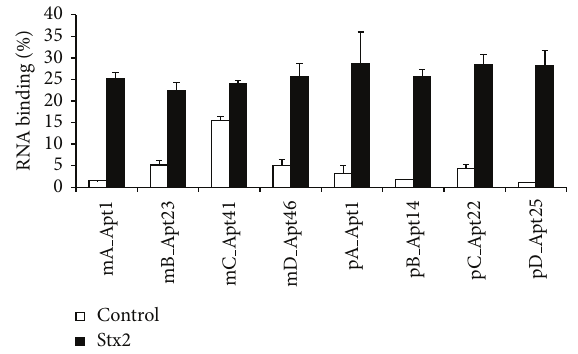
Figure 2: Binding of individual aptamers with Stx2. The binding activity of the individual aptamers with Stx2 was analyzed by filter binding assay. All aptamer sequences showed strong binding with Stx2 except mC Apt41 which showed moderate binding as it also bound nonspecifically to the membrane more than the other aptamers. This experiment was repeated twice with similar